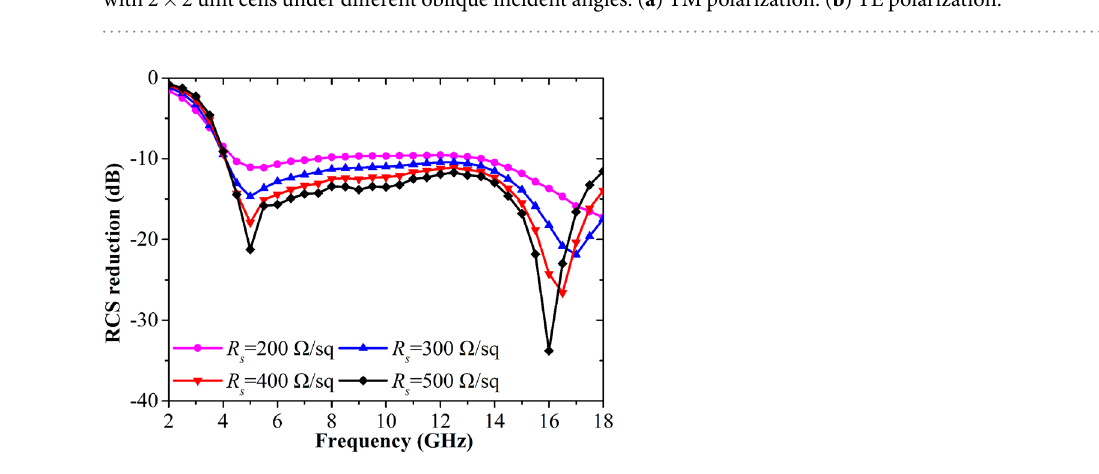
Figure 5. Simulated bistatic RCS reduction performance of the designed 2D grating integrated Salisbury screen with 2 × 2 unit cells under different oblique incident angles. ( a ) TM polarization. ( b ) TE polarization.